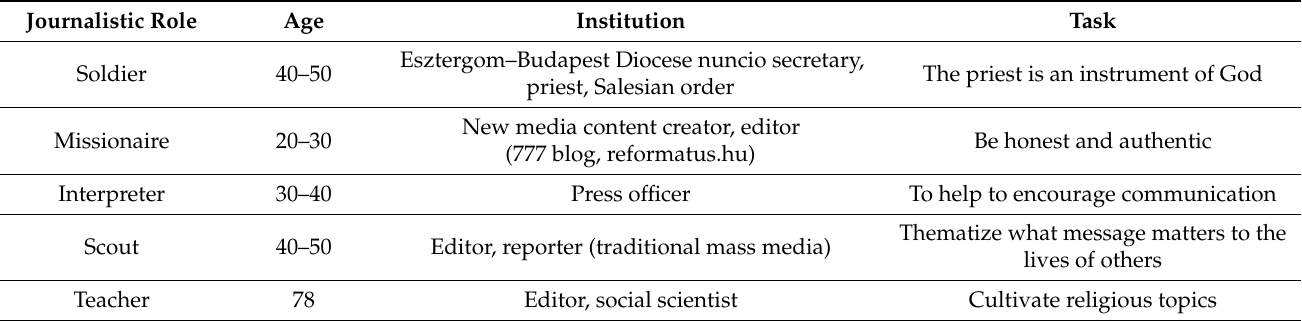
Table 2. Relationship between the role of journalist, age, institution, and